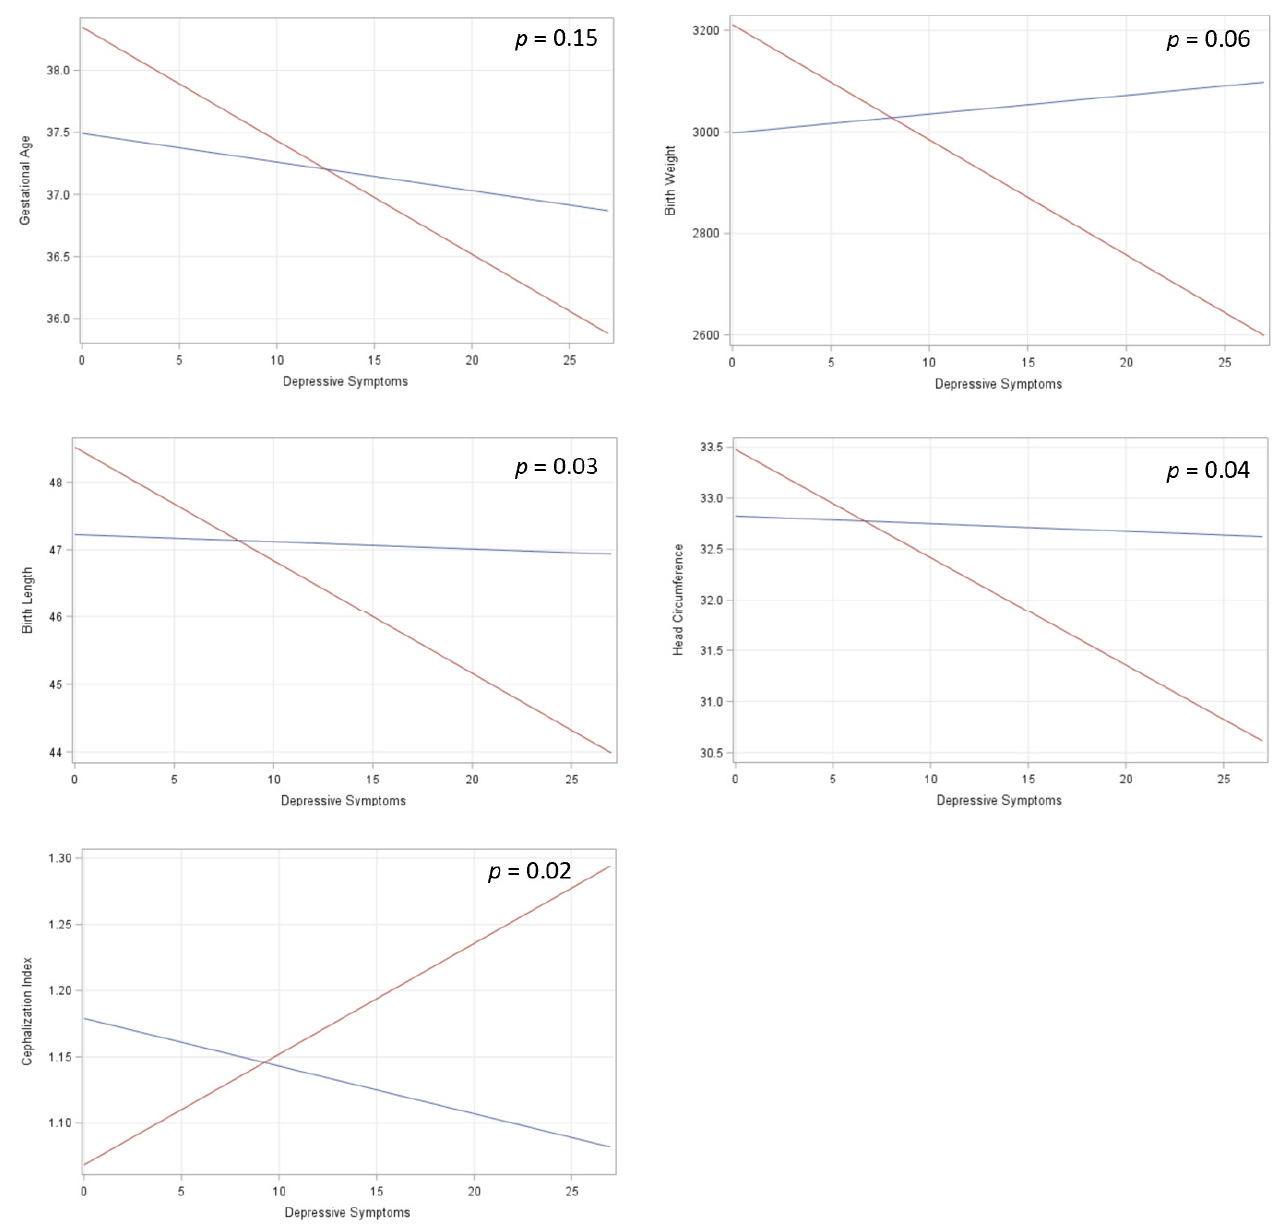
Figure 3. Interaction effects for the joint contribution of prenatal Pb exposure and maternal depression during pregnancy in relation to birth outcomes. Red lines depict slopes for those with high Pb exposure, and blue lines depict slopes for those with lower prenatal Pb exposure. p -values for the interaction effect for Pb and depressive symptoms from each outcome are listed in their respective graphs. Models (final covariates determined via backward elimination): Y GA = β 0 + β Pb + β Depression + β Pb*Depression + β Parity + β Smoker + β DeliveryMode ; Y BW = β 0 + β Pb + β Depression + β Pb*Depression + β Race + β Parity + β Smoker + β Diet + β InfantSex ;Y BL = β 0 + β Pb + β Depression + β Pb*Depression + β Race + β Parity + β Smoker + β Diet; Y HC = β 0 + β Pb + β Depression + β Pb*Depression + β Race + β Age + β Parity + β BMI + β Smoker + β DeliveryMode ; Y Ceph = β 0 + β Pb + β Depression + β Pb*Depression + β Parity + β Smoker + β DeliveryMode.